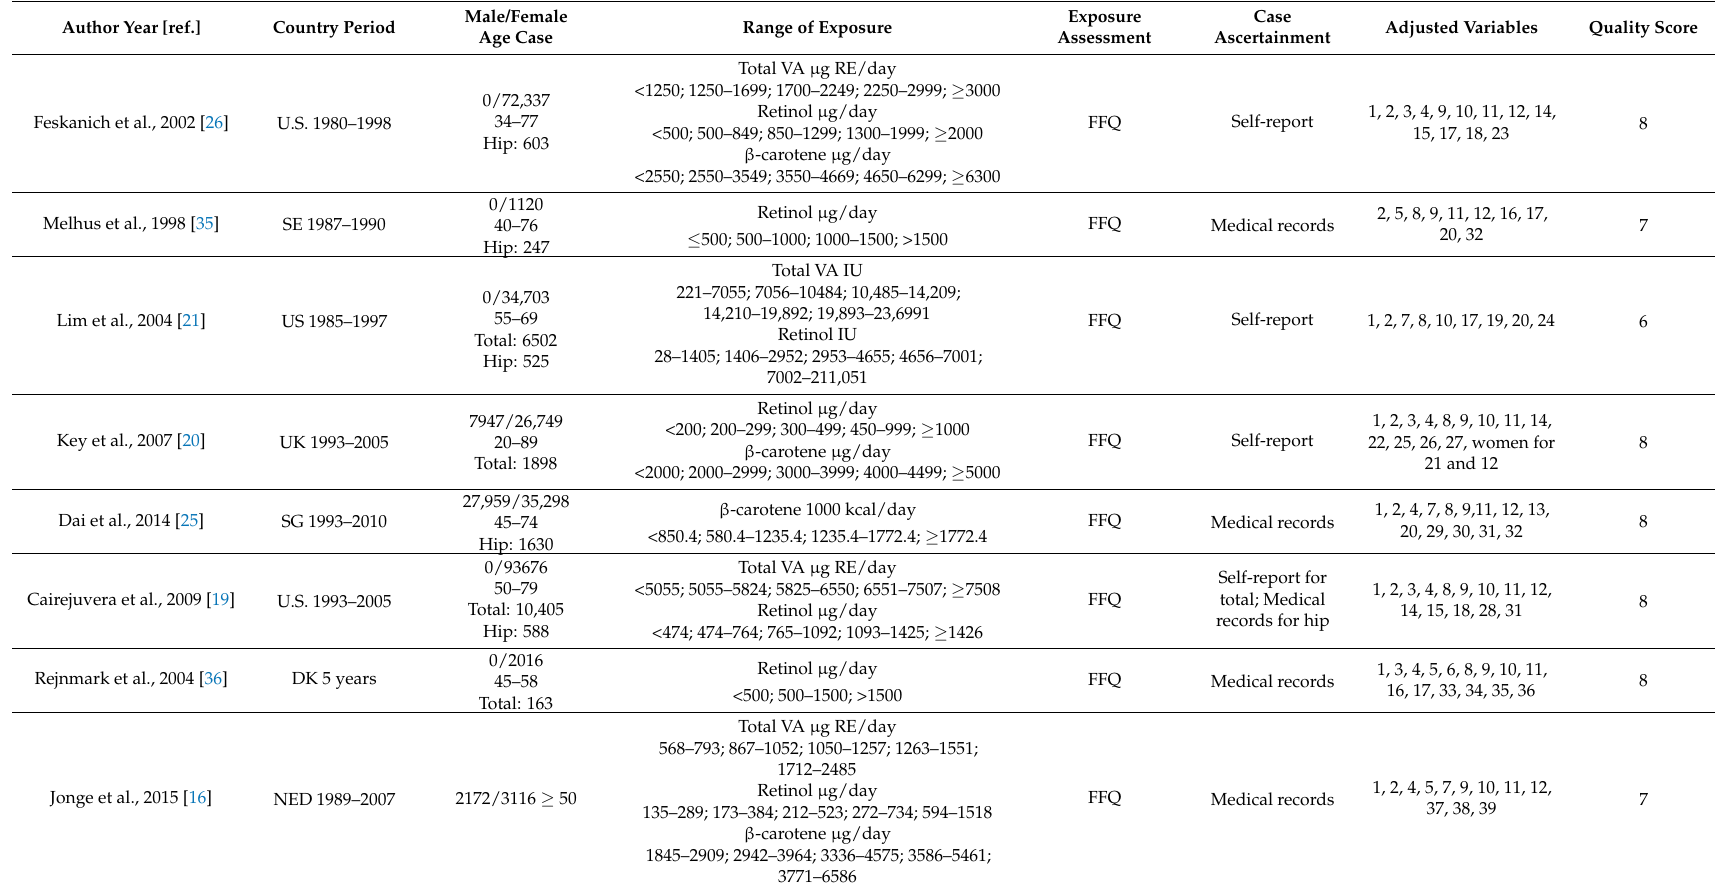
Table 1. Characteristics of studies on VA (total VA, retinol or β -carotene)